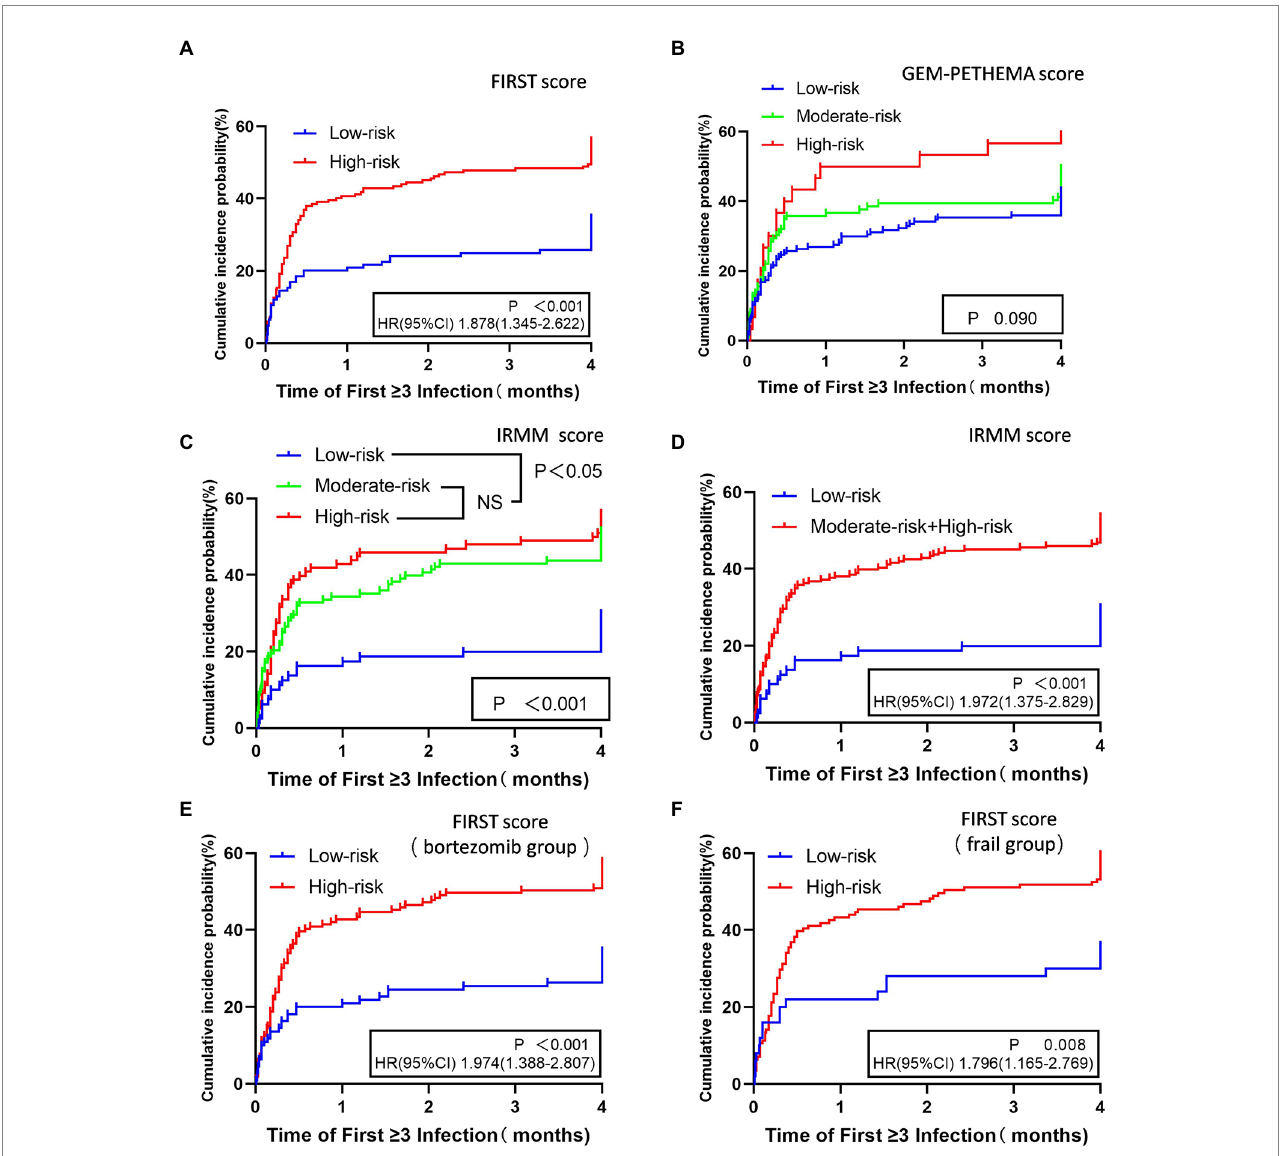
FIGURE 3 Time to first grade ≥ 3 infection in the first 4 months for different stratifications in three models. FIRST score (A) , GEM-PETHEMA score (B) , IRMM score (C,D) , patients treated with bortezomib scored by FIRST score (E) , and frail patients scored by FIRST score (F) . NS No statistical significance, HR Hazard ratio, CI 95% confidence